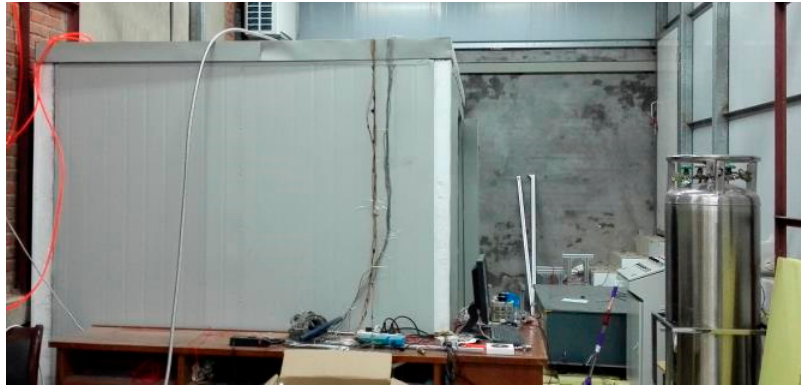
Figure 1. Environmental chamber and refrigeration system used in the experiment.